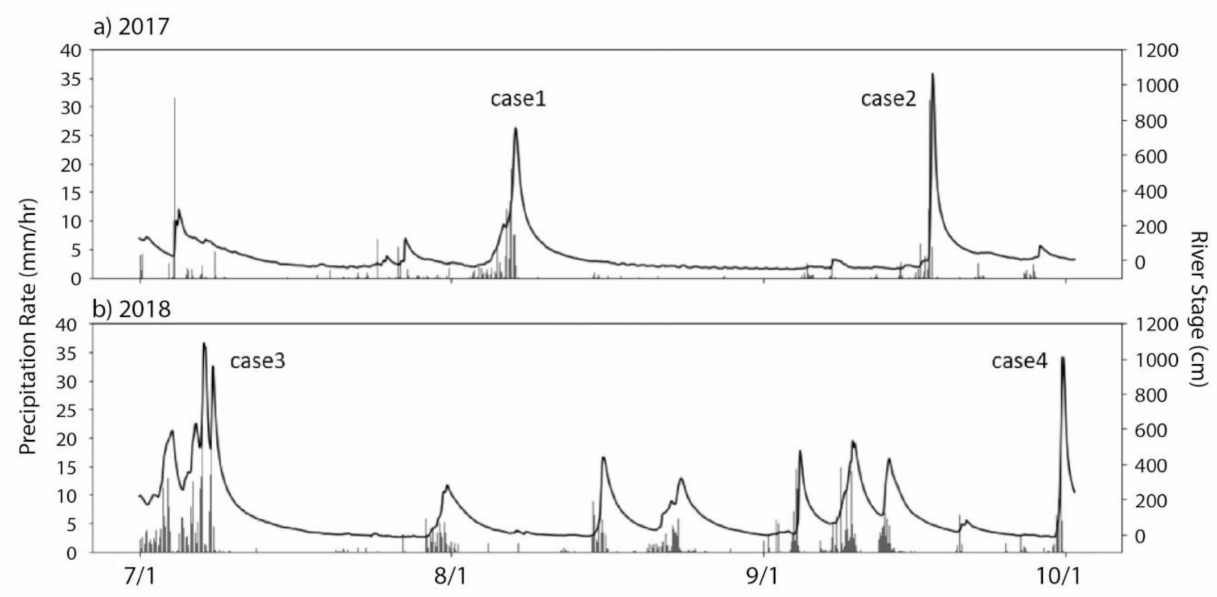
Figure 6. Time series of average precipitation (gray bars) and stage (solid line) in the test dataset. ( a ) For the cases in 2017. ( b ) For the cases in